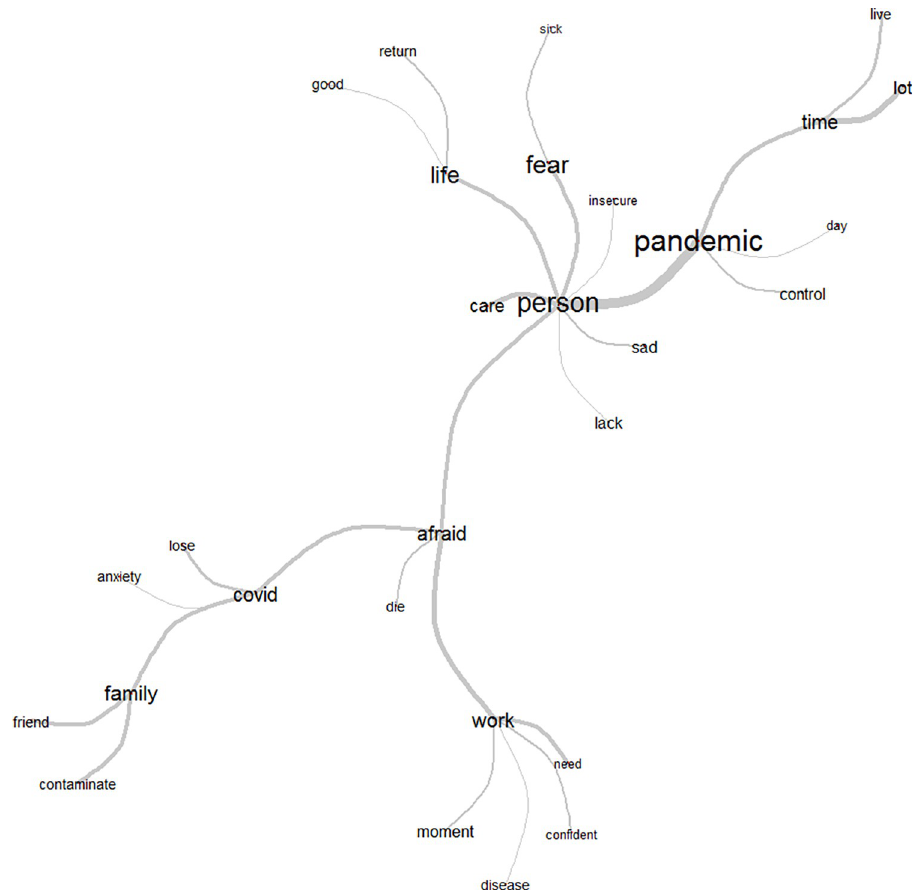
Fig 3. Similarity tree of Class 1: Healthcare workers´ fear of falling ill and infecting family members and friends. Source: COVIDPRO Research Project (2020). Rio de Janeiro–Brazil, 2020. (N =